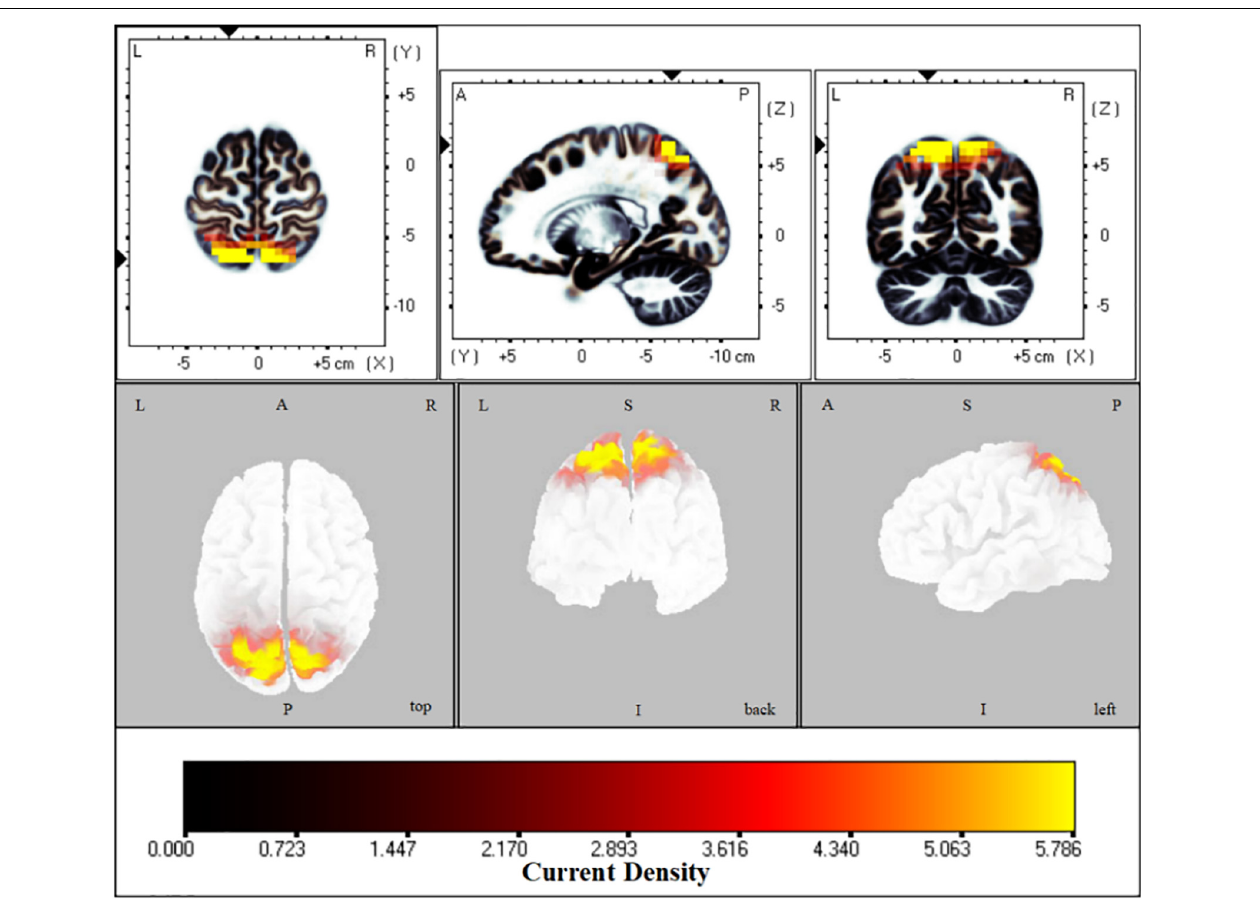
FIGURE 1 | Functional independent component analysis (flCA): Neural oscillation changes in the resting state. Changes of information transmission in the left superior parietal lobule between eyes open and eyes closed states in delta band; The bright yellow indicates increased delta oscillation in the eyes open state. L, left; A, anterior; R, right; P, posterior; S, superior; I,